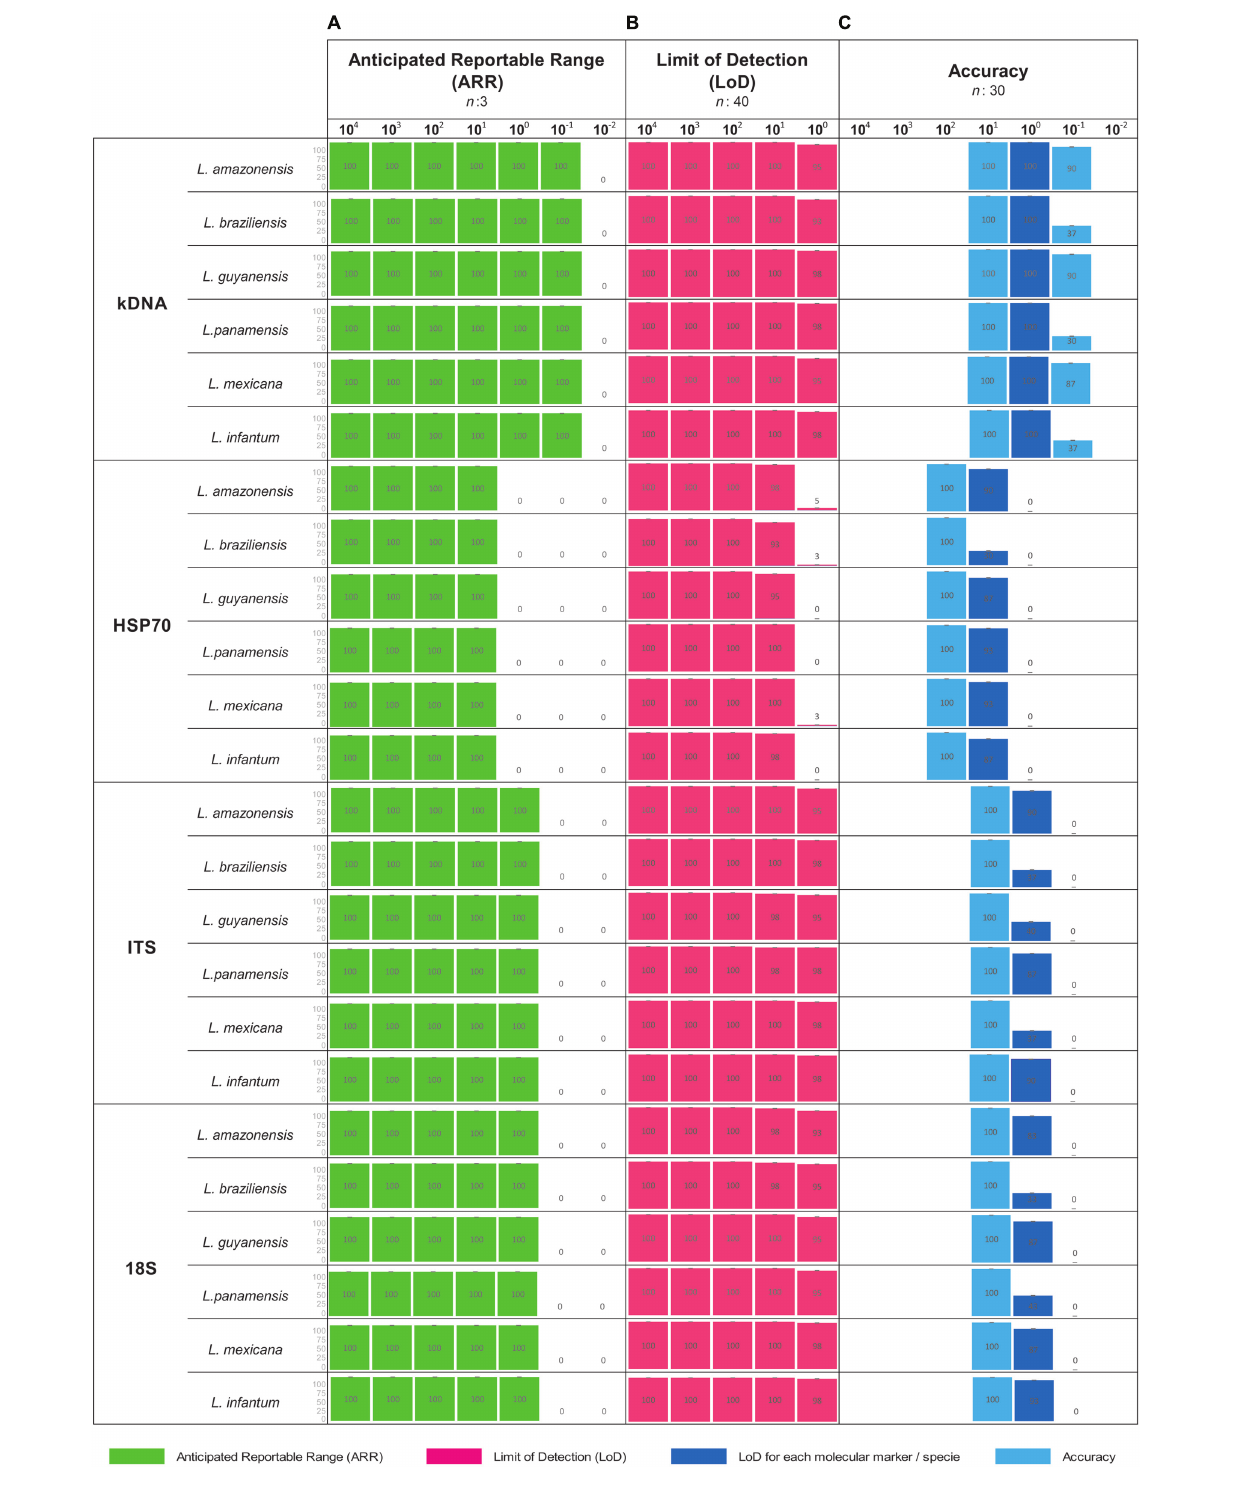
Frontiers in Microbiology |